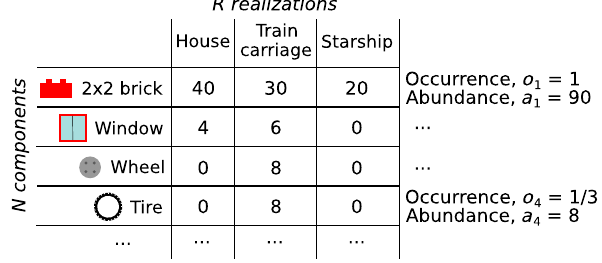
FIG. 1. Matrix representation of complex component